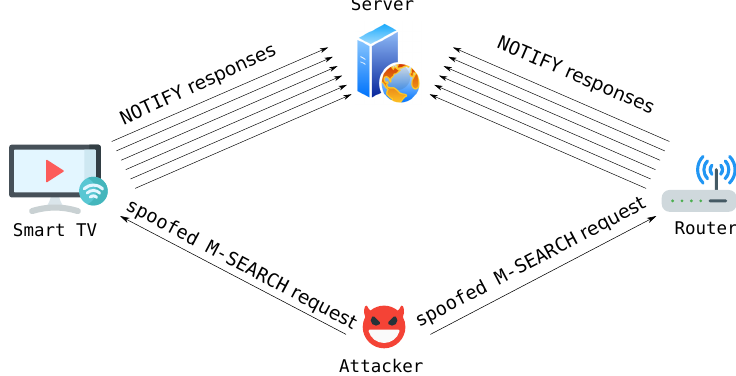
Figure 2. Example of SSDP amplification/reflection DDoS attack toward a